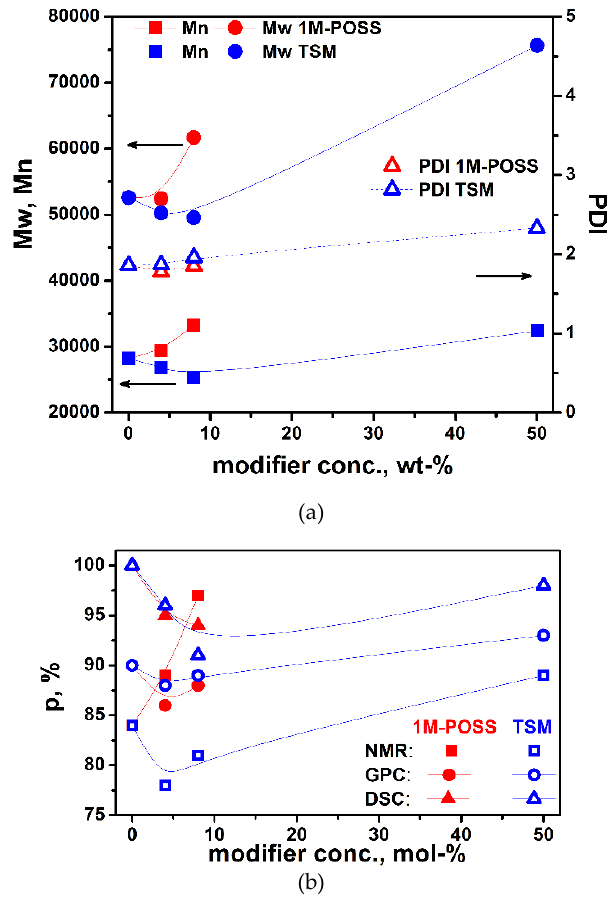
Figure 11 . The dependence of ( a ) the copolymer molecular weight (determined by GPC) and ( b ) the copolymer yield (determined by various methods) on the modifier content. The lines are eye guides.